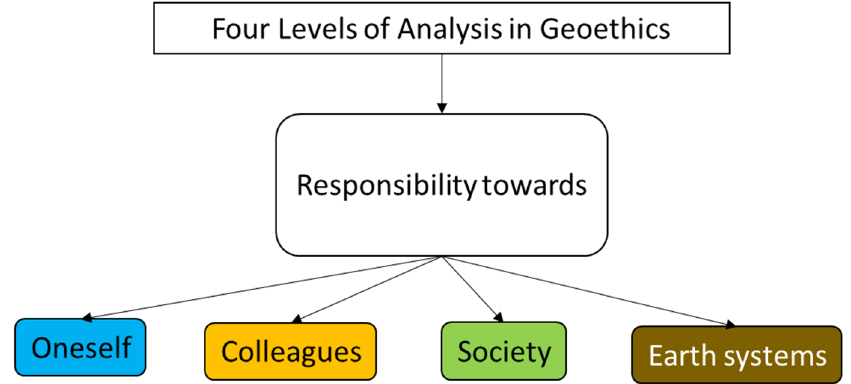
Figure 1. Levels of responsibility in the geoethical framework.